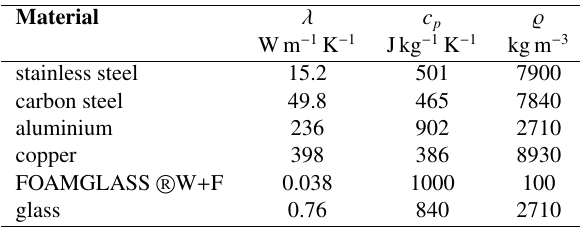
Table 1. Thermophysical properties of widely-used engineering materials at a temperature of 20 ◦ C, see [13] and